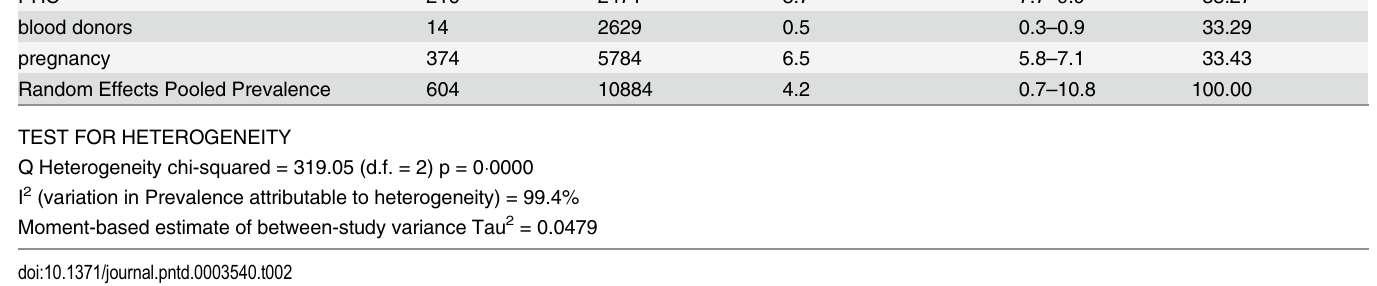
hosting LA migrant population should seriously evaluate the need to address the detection, management and control of Chagas disease. However, concealed within the overall point esti- mate of 4.2% is marked heterogeneity both between and within migrants from different LA countries. The data presented here are a useful starting point for understanding the burden of Chagas disease in migrants to Europe whilst also highlighting the profound knowledge gap and clear need for more systematic, larger scale investigation.